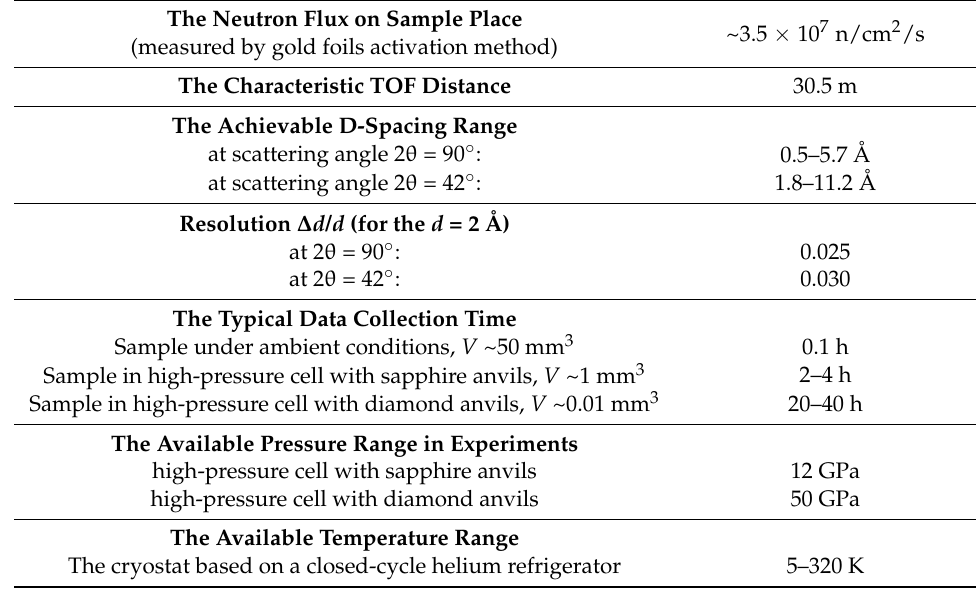
Table 1. The technical parameters of the DN-6 diffractometer and the available experimental